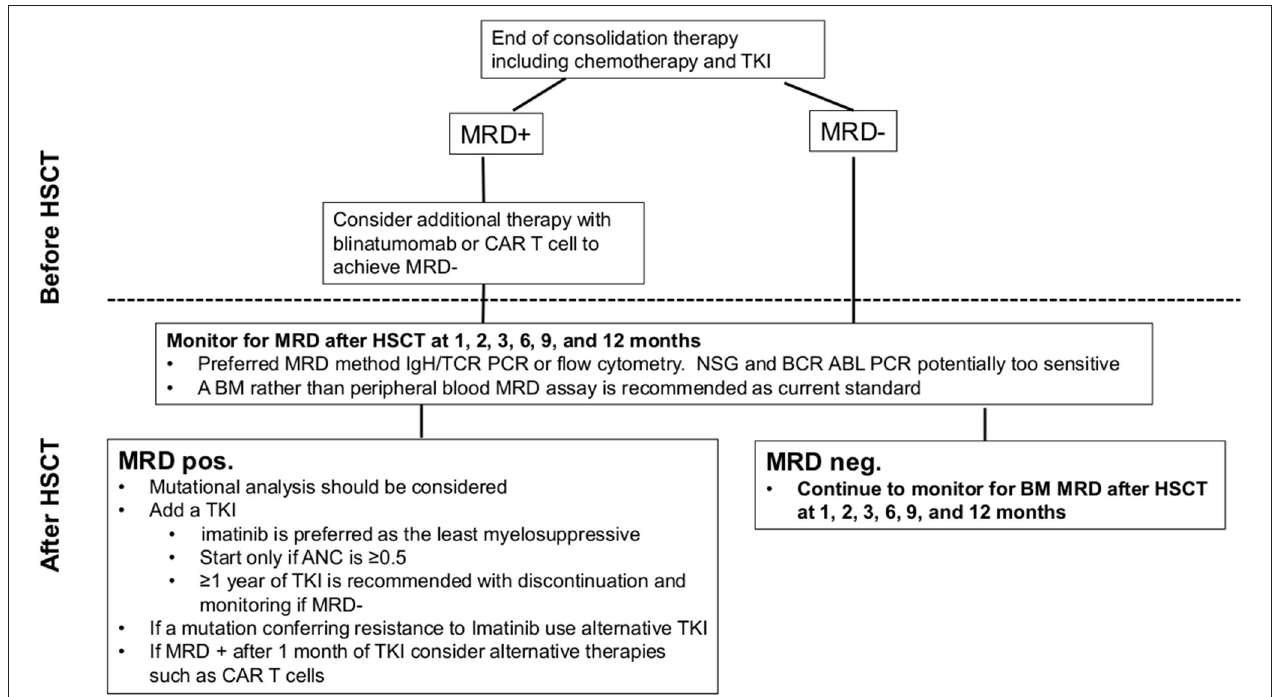
FIGURE 3 | Our recommendations for the use of MRD to plan HSCT in paediatric Ph + and Ph-like ALL. ANC, absolute neutrophil count; ALL, acute lymphoblastic leukaemia; BM, bone marrow; CAR, chimeric antigen receptor; HSCT, haematopoietic stem cell transplantation; IgH, immunoglobulin H; MRD, minimal residual disease; NGS, next-generation sequencing; PCR, polymerase chain reaction; Ph + , Philadelphia chromosome; TCR, T cell receptor; TKI, tyrosine kinase